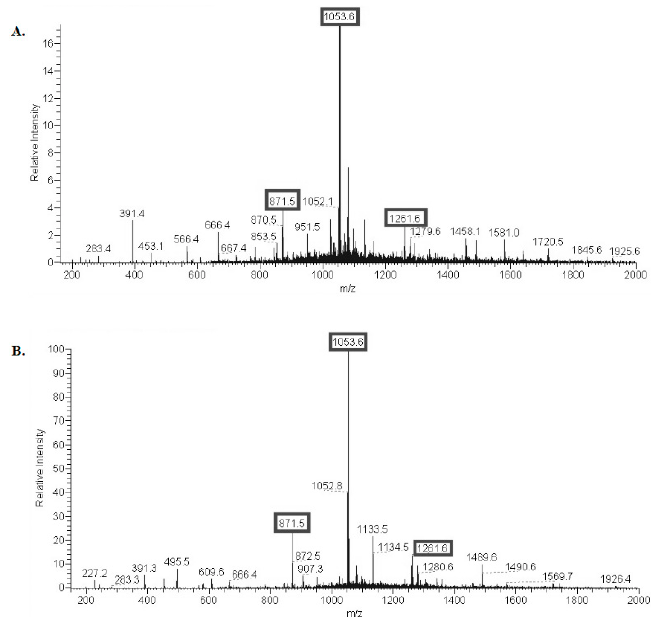
Figure 2. Mass spectra of lipid A (LA) of Ac 3 -S-LPS E. coli O157 ( A ) and of Ac 3 -S-LPS E. coli O104 ( B ). The peak at m/z 1053.6 (major) belongs to tri-acylated LA; peaks at m/z 871.5 and 1261.6 belong to di- and tetra-acylated LA, respectively. All species of LA are monophosphoryl.